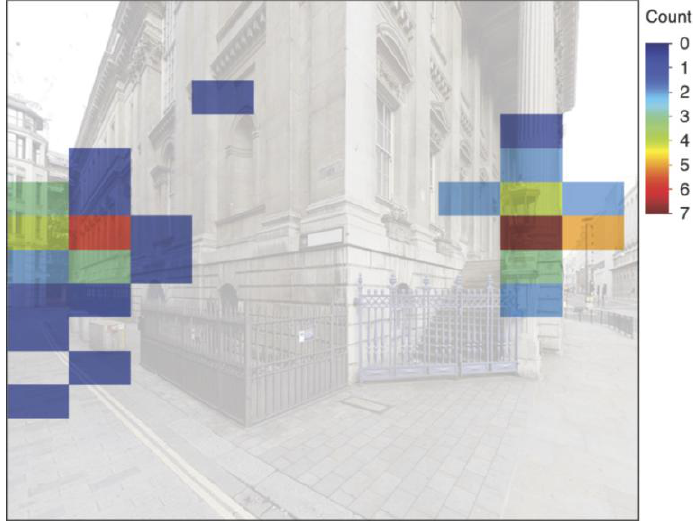
Figure 3. Example distribution of fixations of all participants for one